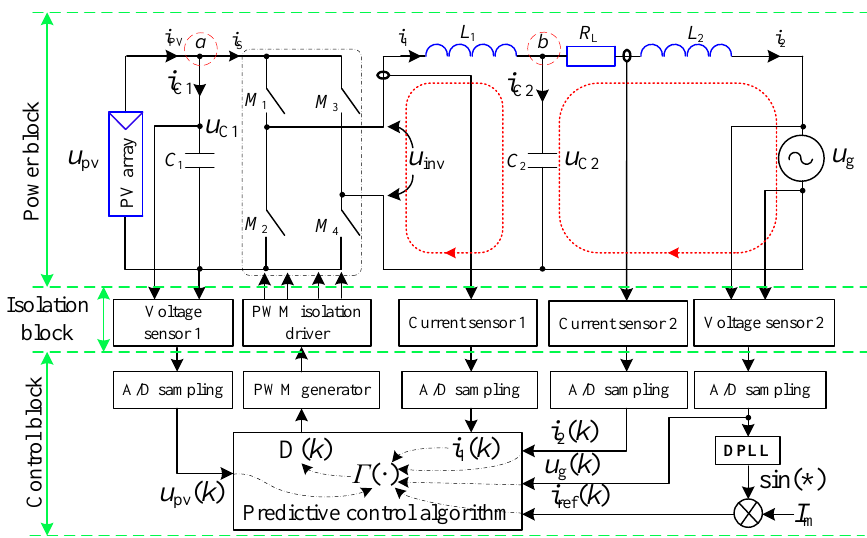
Figure 1. Circuit structure of a photovoltaic grid-connected inverter.